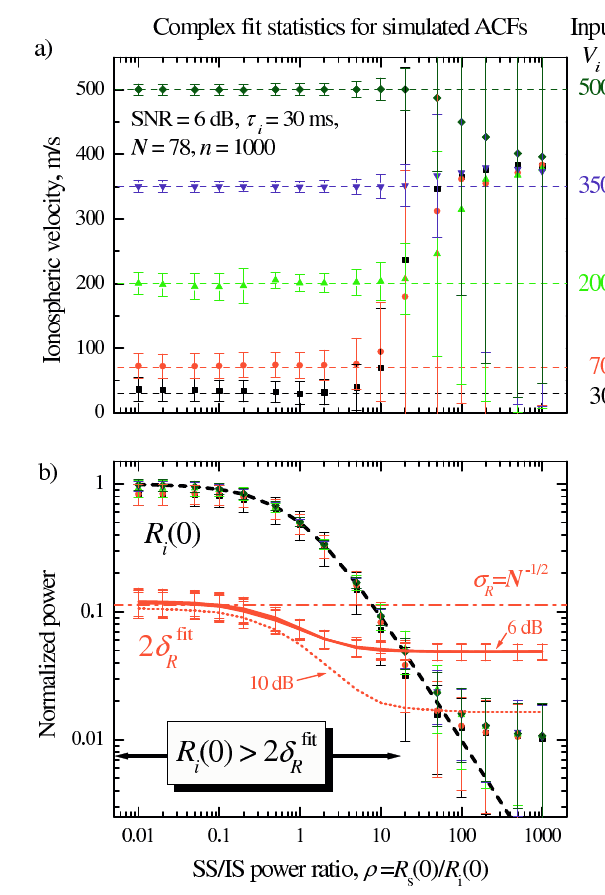
Fig. 5. (a) Dependence of median IS velocity estimate by two- component model on IS/SS power ratio. (b) Same dependence for IS power and doubled fitting error illustrating the selection criterion developed in this paper. The dashed lines in both panels represent simulated (input) parameters while the symbols depict median fit- ting results, and the error bars correspond to one standard deviation.